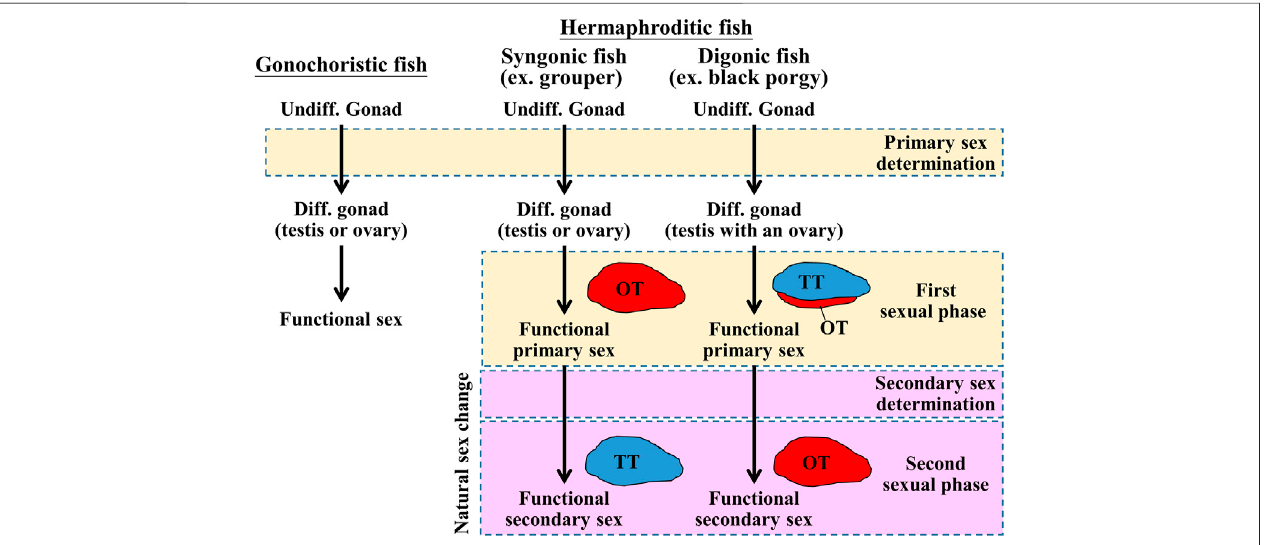
FIGURE1| Schematicdiagramofsexdeterminationandgonadaldifferentiationinteleosts.Sexdeterminationisaprocesstoin fl uencesexualfate.Ingonochoristic fi sh,sexdeterminationresultedinundifferentiatedgonadtodifferentiatedgonad(testisorovary).Thenthetestisorovarydevelopsintoamaturephase(functionalsex).In syngonic fi sh, primary sexdetermination resulted inundifferentiatedgonadto differentiated gonad,then theovary develops into amature phase (functional primary sex). In the natural sex change process, secondary sex determination caused primary sex to secondary sex (male-to-female or female-to-male). In digonic fi sh, such as black porgy, primary sex determination resulted in the change of undifferentiated gonad to differentiated gonad (a bisexual gonad, testis with an ovary), then the gonad develops into functional primary sex (mature testis with regressed ovary). In the natural sex change process, secondary sex determination caused primary sex to secondary sex. Undiff. gonad, undifferentiated gonad; Diff. gonad, differentiated gonad.